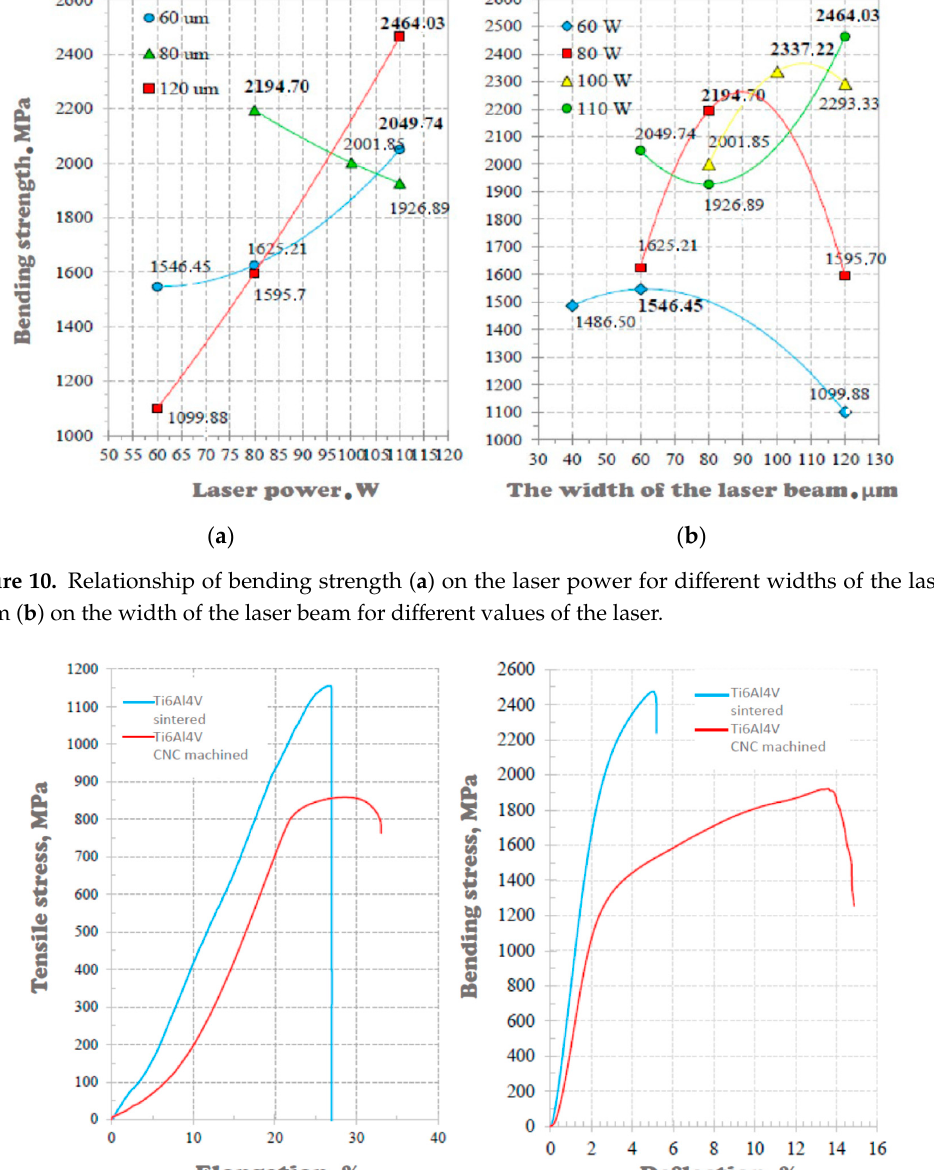
( b ) Figure 12. Comparison of fracture morphology after static bending tests. ( a ) Ti6Al4V casting alloy after milling in a CNC milling centre. ( b ) Sintered alloy using the SLS method (Ti solid 4 variant) (SEM). Furthermore, the fracture analysis does not indicate significant pores or gas bubbles resulting from the casting process. It can, therefore, be concluded that the share of pores in casting alloys is relatively small.